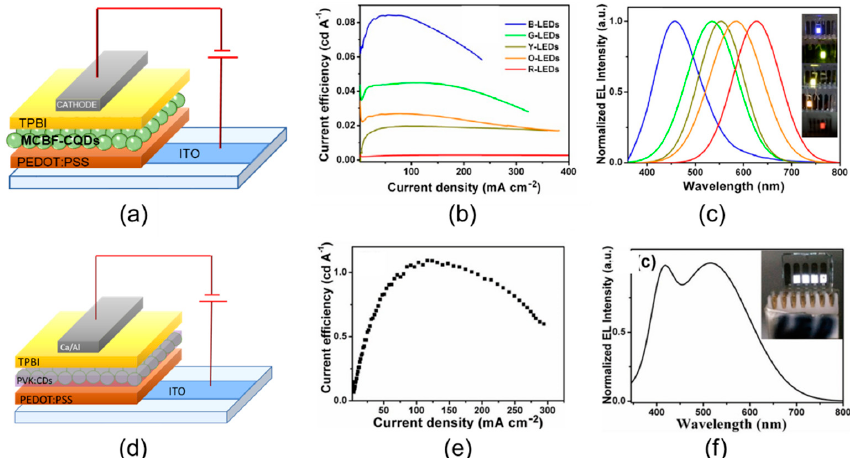
Figure 13. ( a ) Schematic representation of the multicolor blue-to-red fluorescent CD (MCBF-CD)-based device architectures, ( b ) η c vs. J of MCBF-CD-based monochrome electroluminescent OLEDs from blue to red, ( c ) normalized EL spectra (in the inset is a picture of the working devices), ( d ) schematic representation of the PVK:MCBF-CD–based device architectures, ( e ) η c vs. J of PVK:MCBF-CD-based monochrome electroluminescent OLEDs from blue to red, ( f ) normalized white EL spectra (in the inset is a picture of the working devices), ( b , c ) reproduced with permission from Reference [65], copyright 2016 Wiley-VCH, and ( e , f ) reproduced with permission from [14], copyright 2019 American Chemical